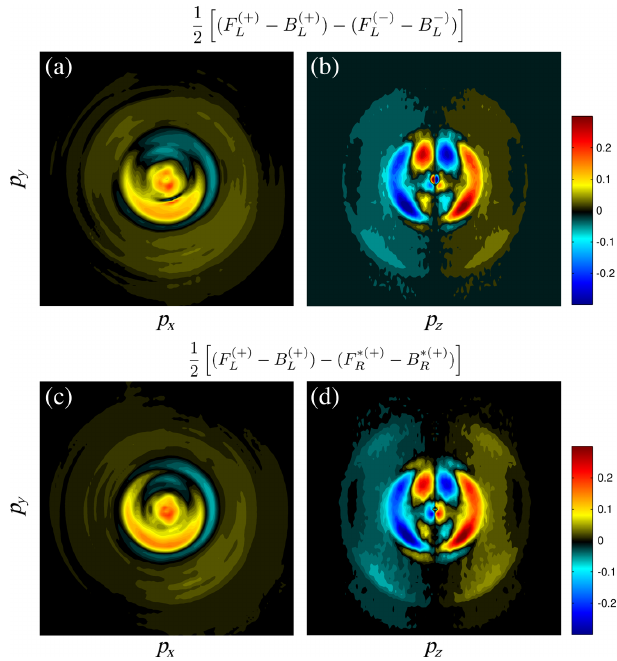
FIG. 9. Comparison of the two differential measurements in camphor molecules subject to a bicircular field with I ¼ 8 × 10 12 W · cm − 2 and r ¼ I =I 1 . (a) Chiral response in 2 ω ω ¼ the forward hemisphere projected in the laser polarization plane and (b) chiral response projected in the ð y; z Þ plane, obtained by differential measurements on opposite enantiomers at fixed polarization. (c),(d) The same as (a),(b) but obtained by differ- ential measurements with opposite field polarizations for a given enantiomer.